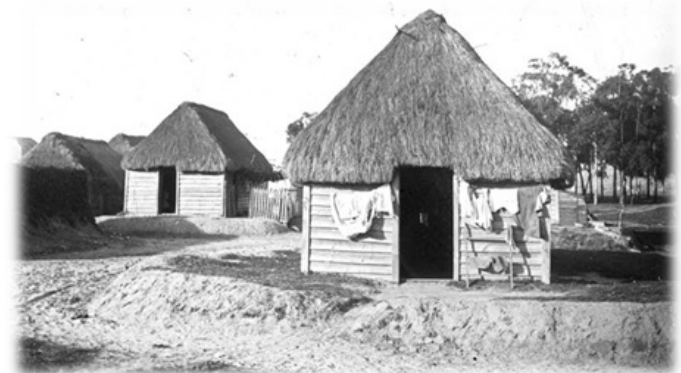
Figure 3. Image of the Caparica’s wooden huts available in Lisbon municipal archive (PT/AM-